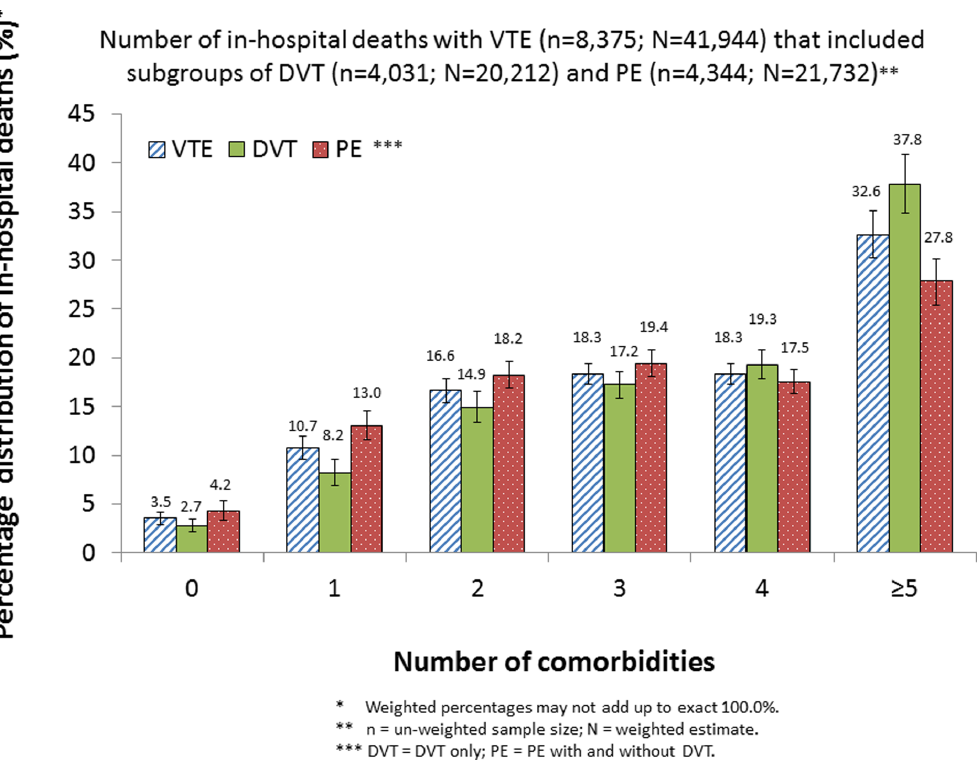
Figure 1. Estimated percentage distribution of in-hospital deaths with a diagnosis of VTE and among those with DVT or PE by number of comorbidity, NIS, 2010.